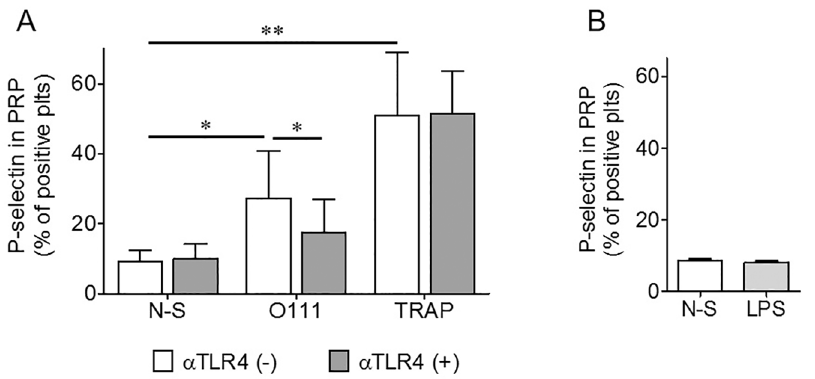
Fig 1. P-selectin expression in platelets stimulated by E . coli O111. Human platelets were activated with E . coli for 30 min at 37˚C, in a ratio 1:10 (platelet: bacteria). The CD62P expressioninducedby the strain O111 was significantly highercomparedwith non-stimulated platelets( * p = 0.03, n = 6), but lower than the responseto TRAP ( ** p= 0.004, n = 5). Previousinhibitionof platelet TLR4, reducedsignificantly the exposureof P-selectin inducedby the bacteria ( * p = 0.03, n = 6). TLR4 inhibitionhad no effect on P-selectin expressionin TRAP-stimulated platelets(A). Platelets in PRP, stimulatedwith LPS (10 μ g/mL) did not show signs of activation(n = 5) (B). The data was analyzedby Wilcoxon signed rank test,